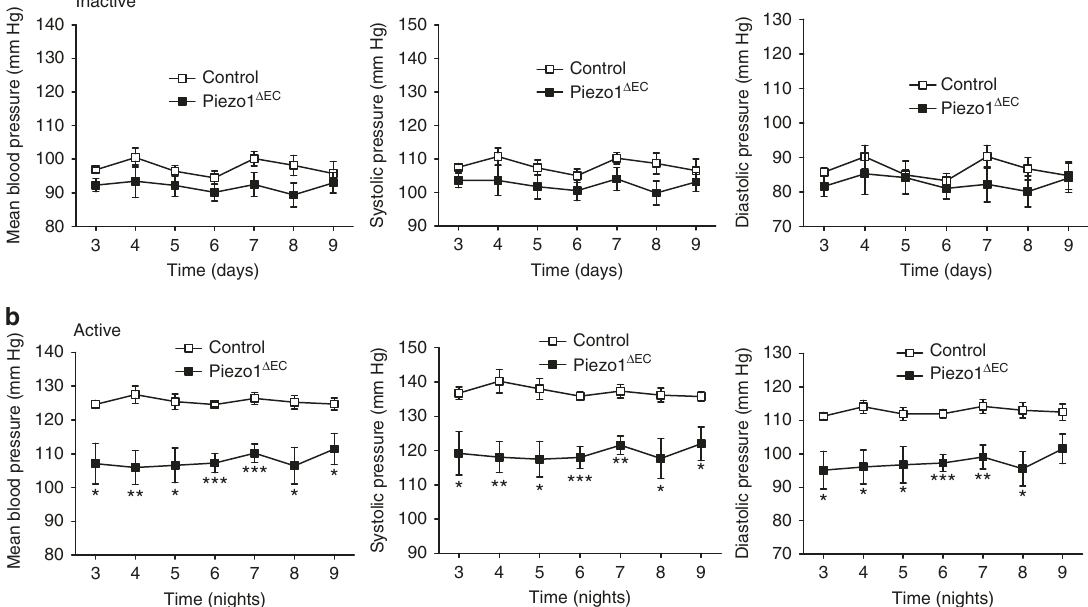
Fig. 3 Importance for elevated blood pressure during whole body physical activity. Telemetry measurements of mean, systolic and diastolic blood pressures in conscious freely moving control ( n = 6) and Piezo1 Δ EC ( n = 7) mice. Data were analysed when the mice were inactive during the day a and voluntarily active on a running wheel during the night b . Time zero is when the mouse was introduced to the running wheel cage. Measurements were not made during the fi rst 2 days of acclimatization. Averaged data are displayed as mean ± s.e.m. Data sets are compared by t -test. Statistical signi fi cance is indicated by * P < 0.05, ** P < 0.01, *** P <